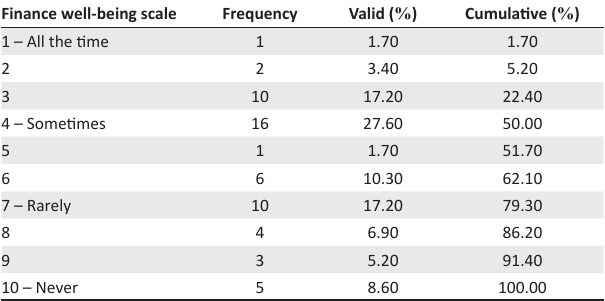
TABLE 4: How often do you worry about being able to meet normal monthly living